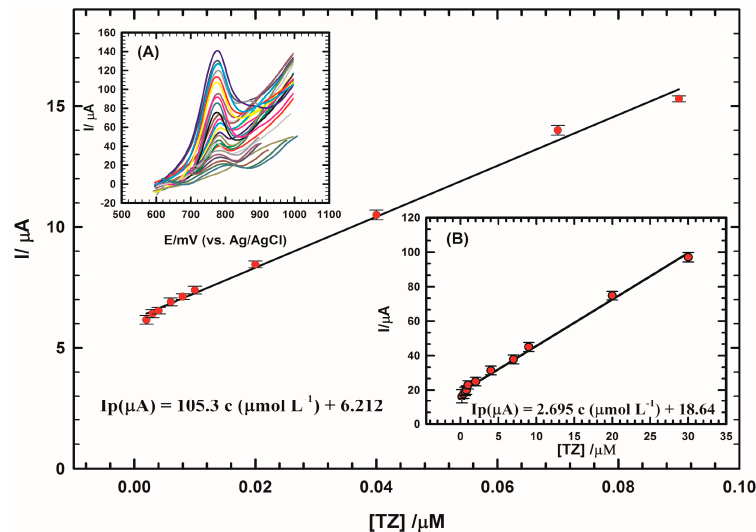
Figure 7. Calibration curve for TZ in the linear range (0.002 μ mol·L − 1 –0.09 μ mol·L − 1 ) at ILCCPE…SDS electrode. Insets: ( A ) DPVs of TZ in urine at ILCCPE…SDS for concentrations from (0.002 μ mol·L − 1 to 30 μ mol·L − 1 ); and ( B ) calibration curve for TZ in the linear range (0.2 μ mol·L − 1 –30 μ mol·L − 1 ) at ILCCPE…SDS. Table 3. Comparison of TZ determination at various modified electrodes-based literature reports.